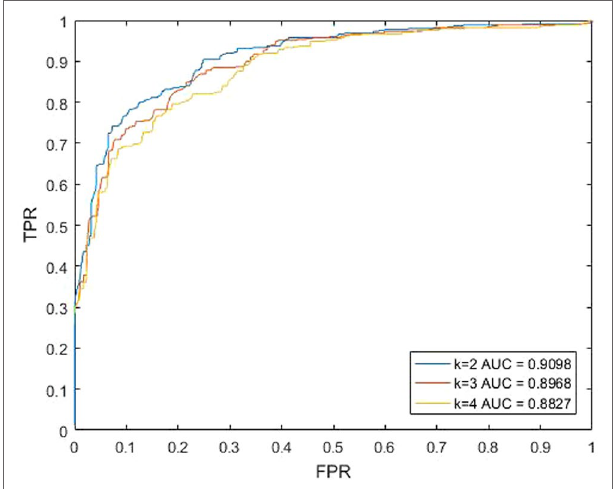
FIGURe 3 | The predictive performances of KATZBNRA with different